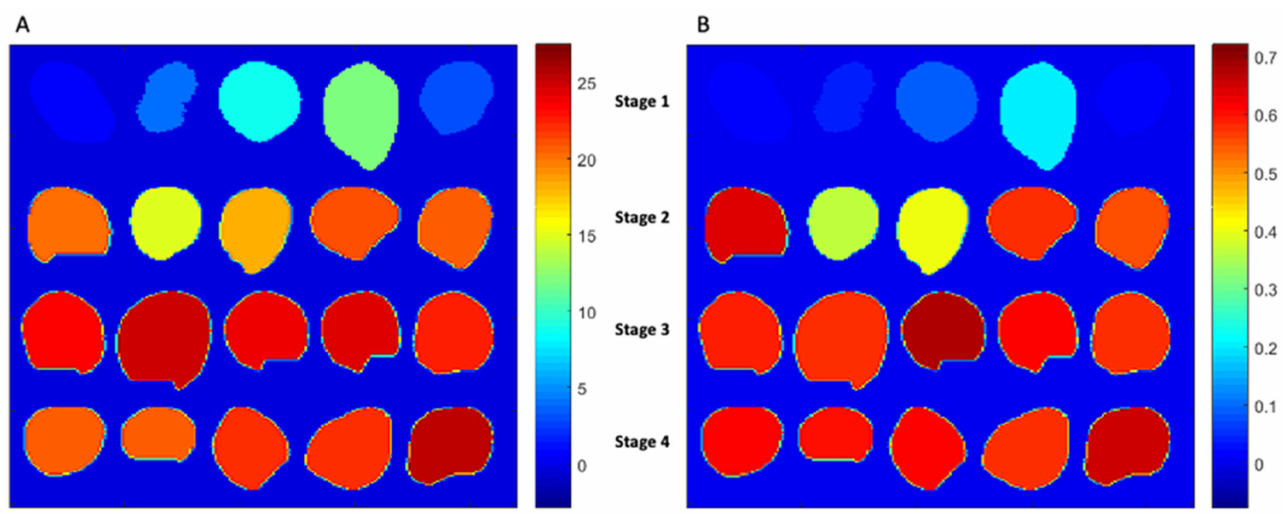
Figure 4. ( A ) SSC (VIS-NIR range) and ( B ) TA (VIS-NIR range): PLS regression plot for predicted vs. measured values.